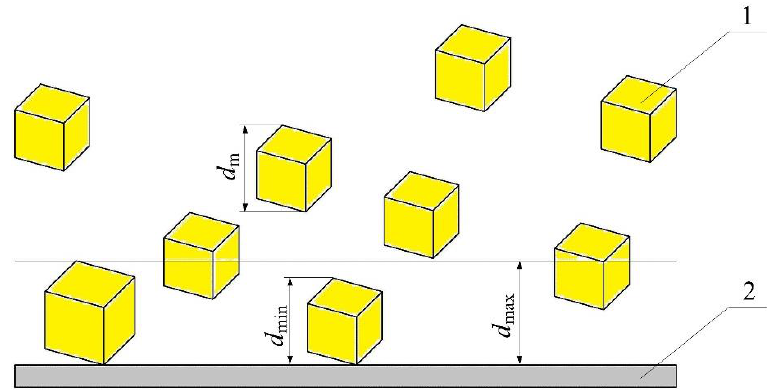
Figure 4. Distribution of abrasive particles in abrasive flow: 1, particles; 2, workpiece.